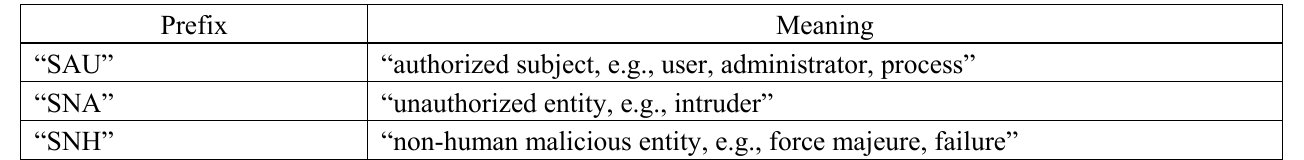
Table 3. Family field defining subjects and other active